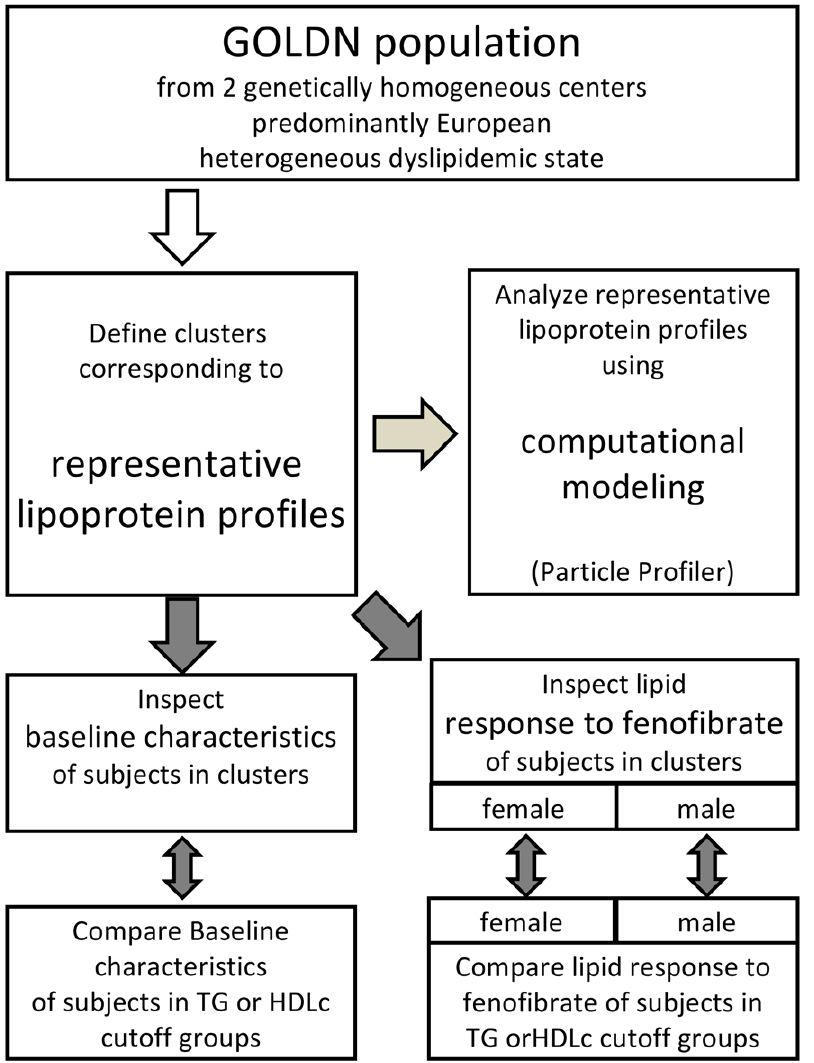
Figure 1. Overview of the data analysis approach presented in this paper. Clustering was carried out to identify representative lipoprotein profiles. The computational model analyzed those representative lipoprotein profiles. In the corresponding subgroups baseline characteristics and the lipid response to fenofibrate intervention was studied. The results of the subgroup studies were compared to the baseline characteristics and lipid response to fenofibrate in subgroups identified using triglyceride or HDL cholesterol cut-off methods.